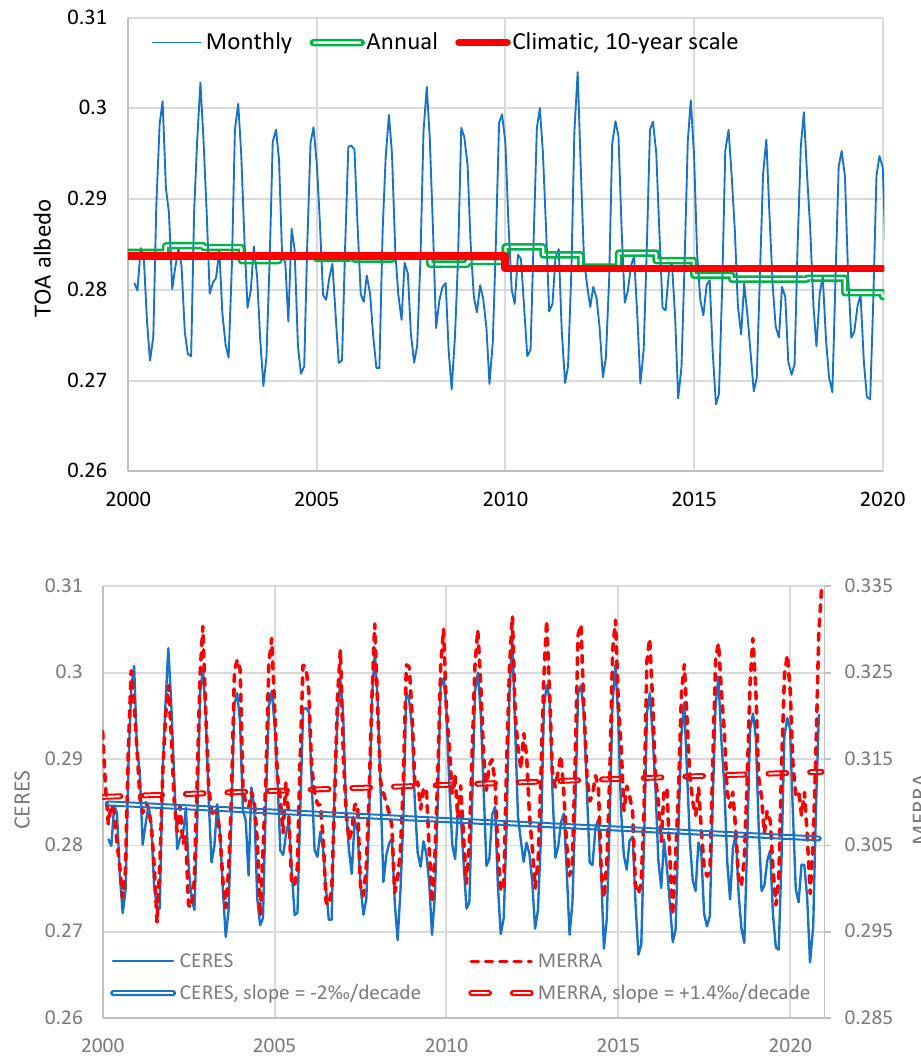
Figure A5. ( Upper ) TOA albedo time series, as provided by NASA’s Clouds and the Earth’s Radiant Energy System (CERES); ( lower ) the same series on annual time scale in comparison of the MERRA-2 series (Figure A4, upper panel) along with linear trends plotted for both series with fitted slopes shown in the legend.